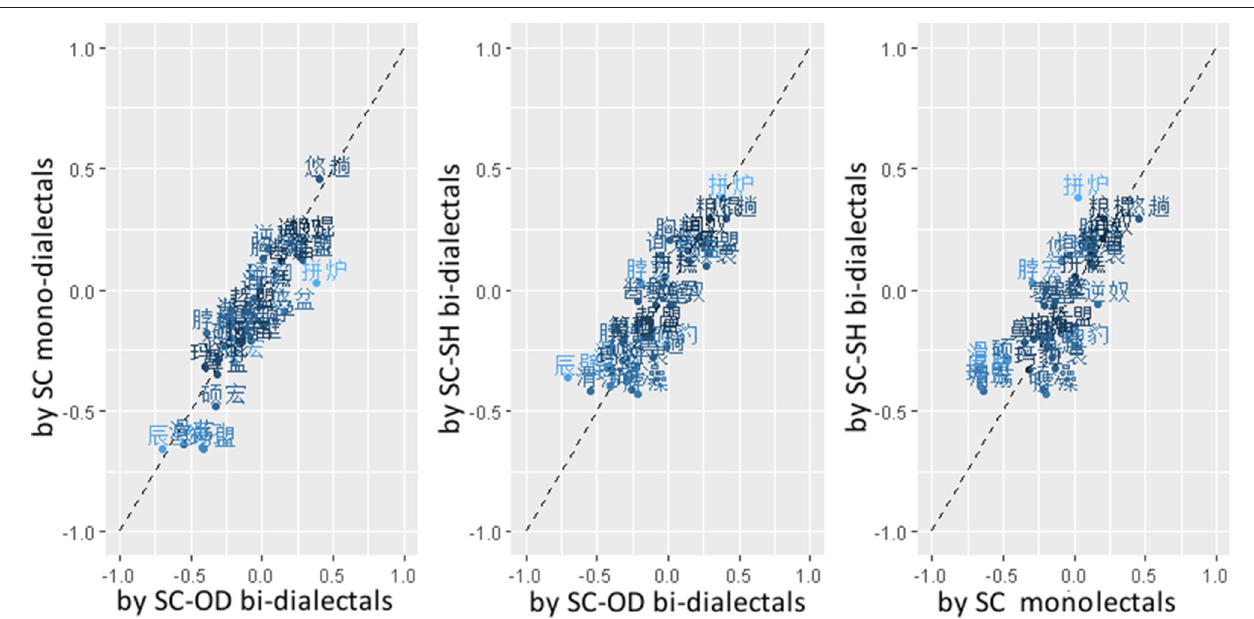
FIGURE 4 | Scatter plots for scaled cross-dialectal similarity ratings of novel ETE pairs (represented with Chinese characters), by SC mono-dialectals (along the vertical axis in the left panel and the horizontal axis in the right panel), SC-SH bi-dialectals (along the vertical axes in the middle and right panels), SC-OD bi-dialectals (along the horizontal axes in the left and middle panels). The deeper color indicates higher